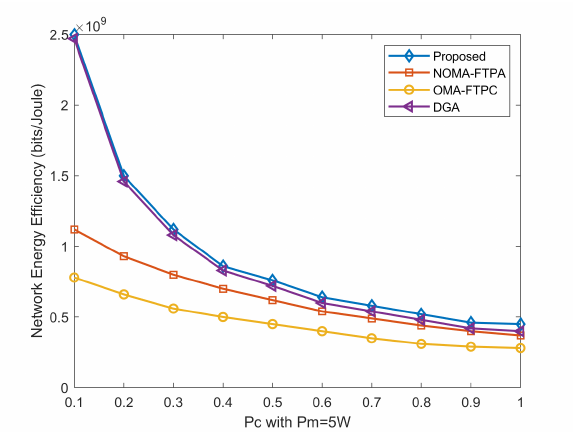
Figure 7. Network EE for different p c